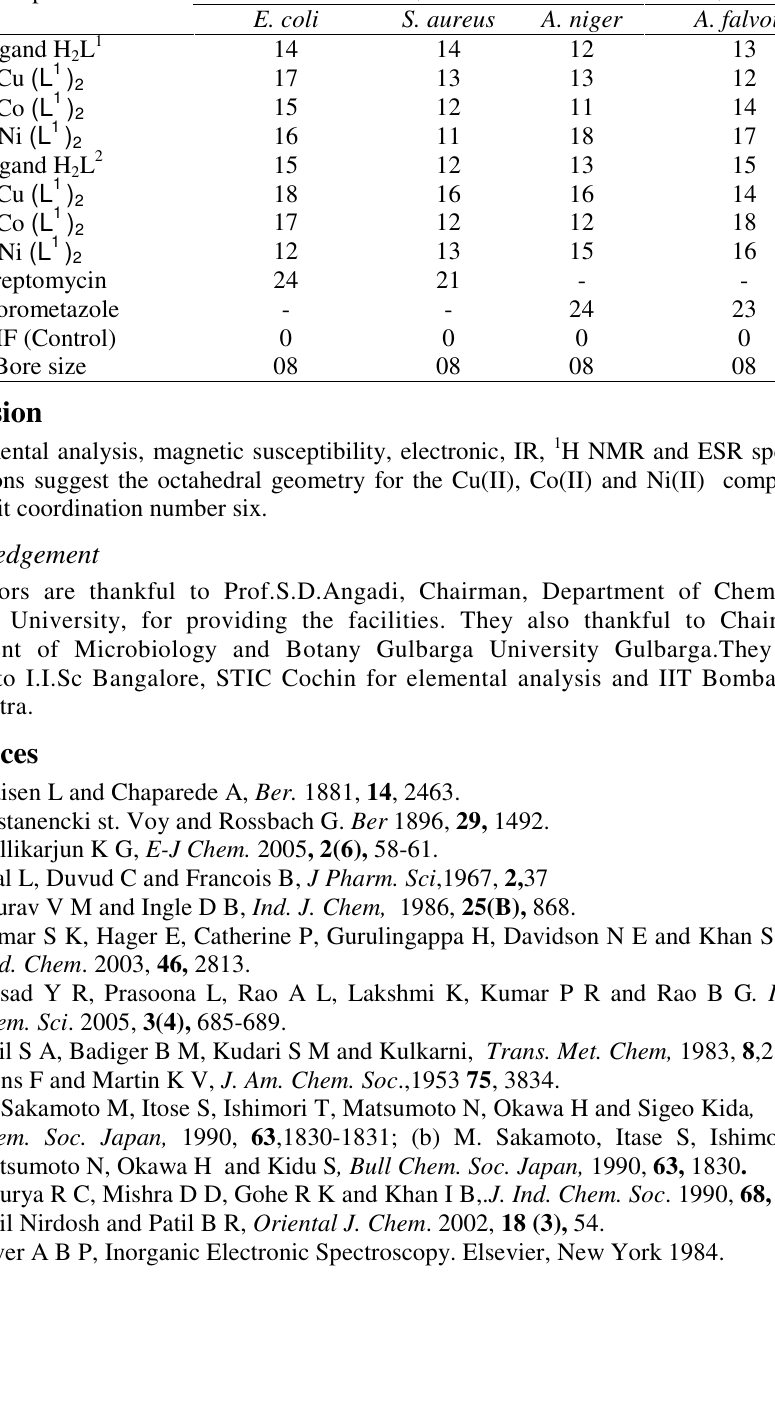
L 1 & H L 2 and its complexes 2 2 Antifungal Activity of zone of inhibition, mm Compound